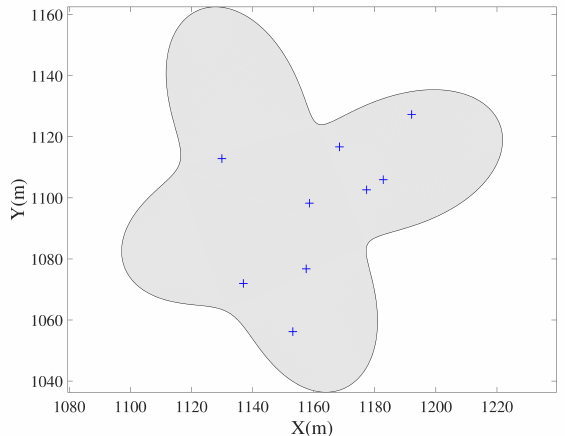
Figure 6. Star-convex extended target and its